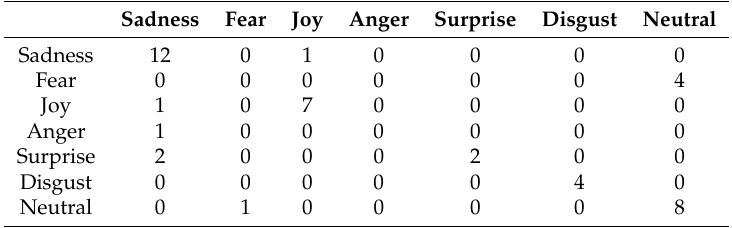
Table A20. A3 actor confusion matrix from the Emo-DB in the third phase.